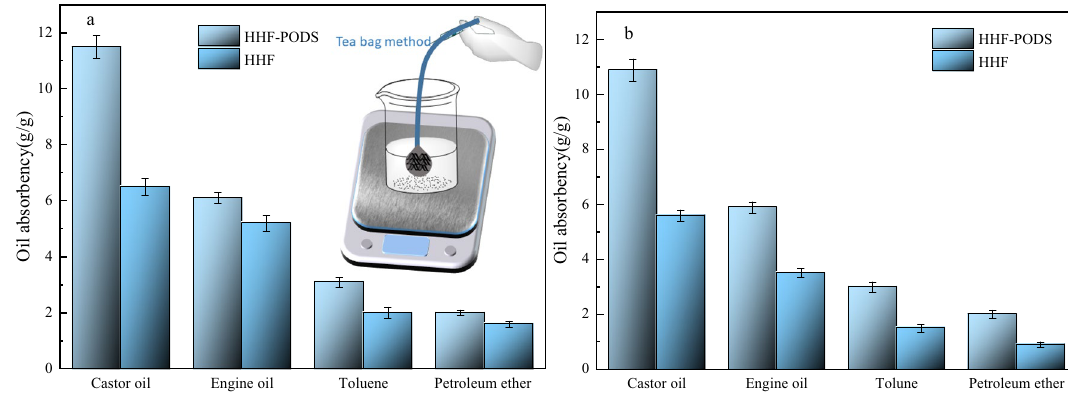
Figure 4. Maximum absorption capacity of HHF and HHF-PODS for different oils in the pure oil system ( a ) and the oils floating on the water surface system ( b